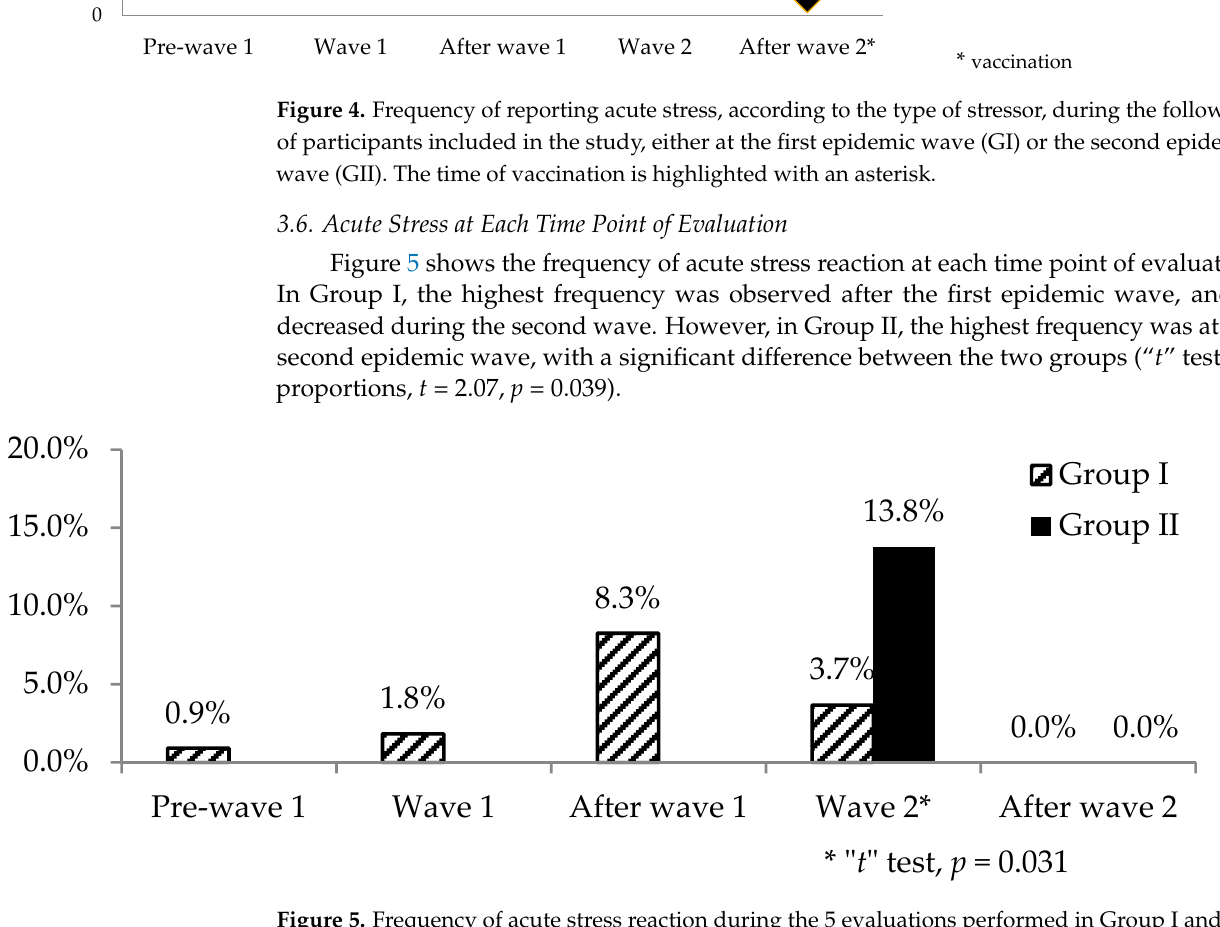
Figure 5. Frequency of acute stress reaction during the 5 evaluations performed in Group I and the 2 evaluations performed in Group II. A significant difference is highlighted with an asterisk.